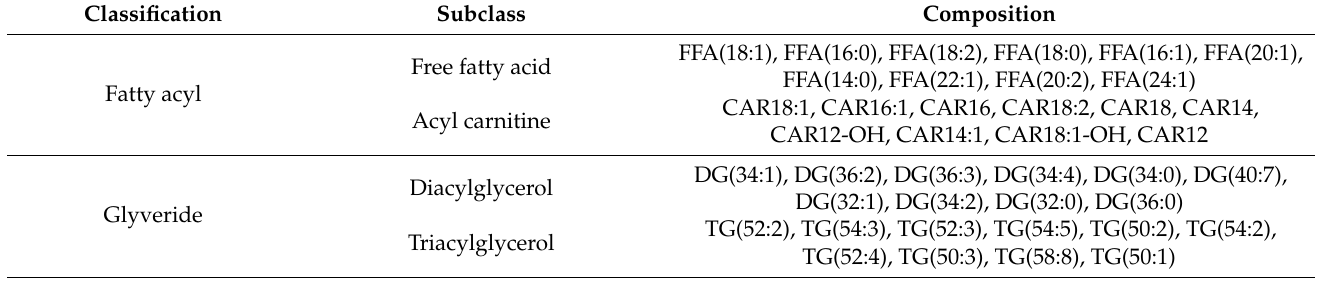
Table 8. Major lipid composition in the liver of largemouth